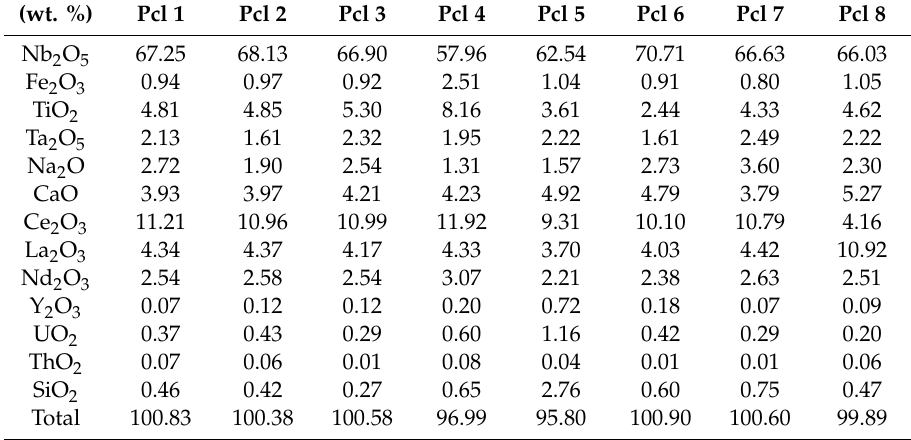
Table 7. Elemental composition of representative pyrochlore grains from sampled parts of the Khalzan Buregtei